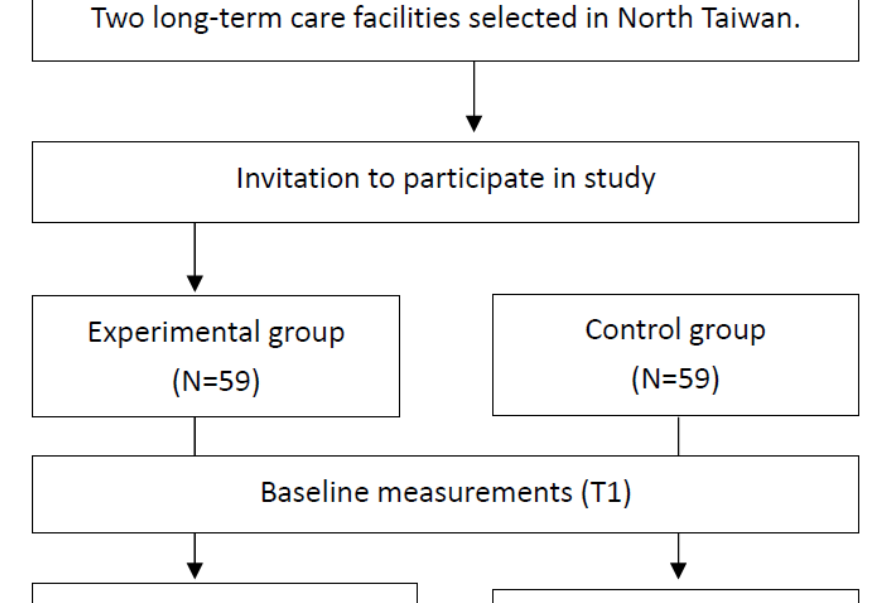
Figure 1. Flowchart of participant enrollment and